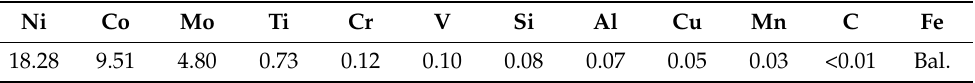
Table 1. Chemical composition (wt %) of maraging 300